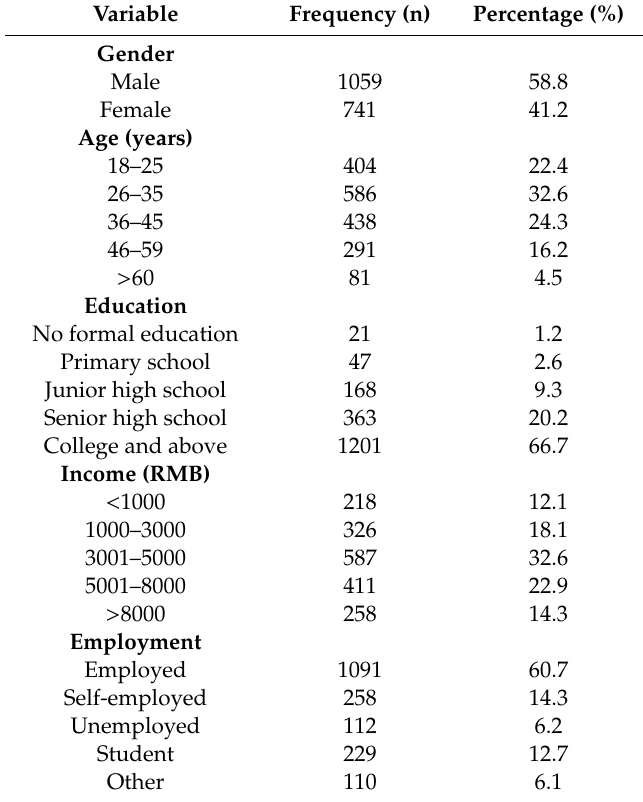
Table 1. Demographic information of customers ( n =